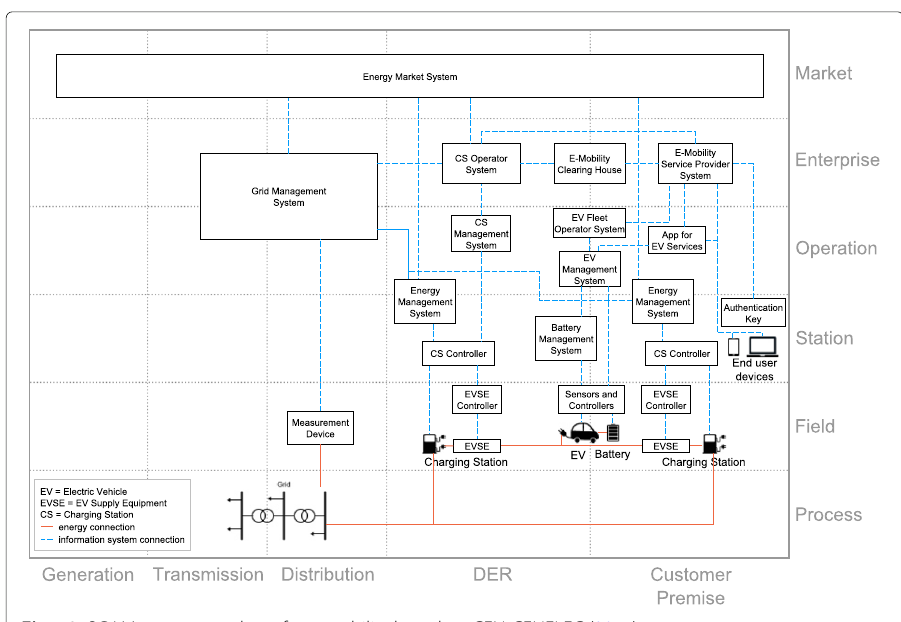
Fig. 13 SGAM component layer for e-mobility based on CEN-CENELEC